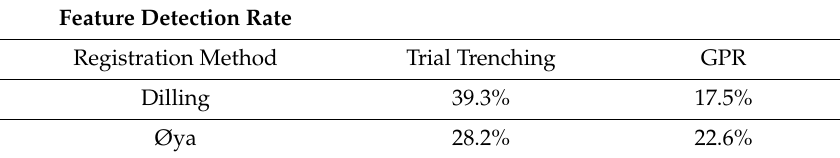
Table 5. Feature detection rate between the two evaluation